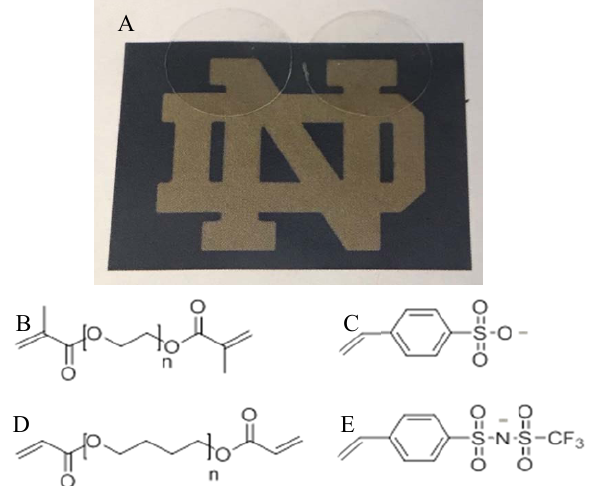
Figure 2. ( A ) Photograph of dry transparent freestanding crosslinked SIPEs, PEGDMA1000_low_SSCa (left) and PEGDMA1000_low_STFSICa (right). ( B ) Poly(ethylene glycol) dimethacrylate (PEGDMA). ( C ) Styrene sulfonate (SS). ( D ) Poly(tetrahydrofuran) diacrylate (PTHFDA). ( E ) 4-styrenesulfonyl (trifluoromethylsulfonyl)imide